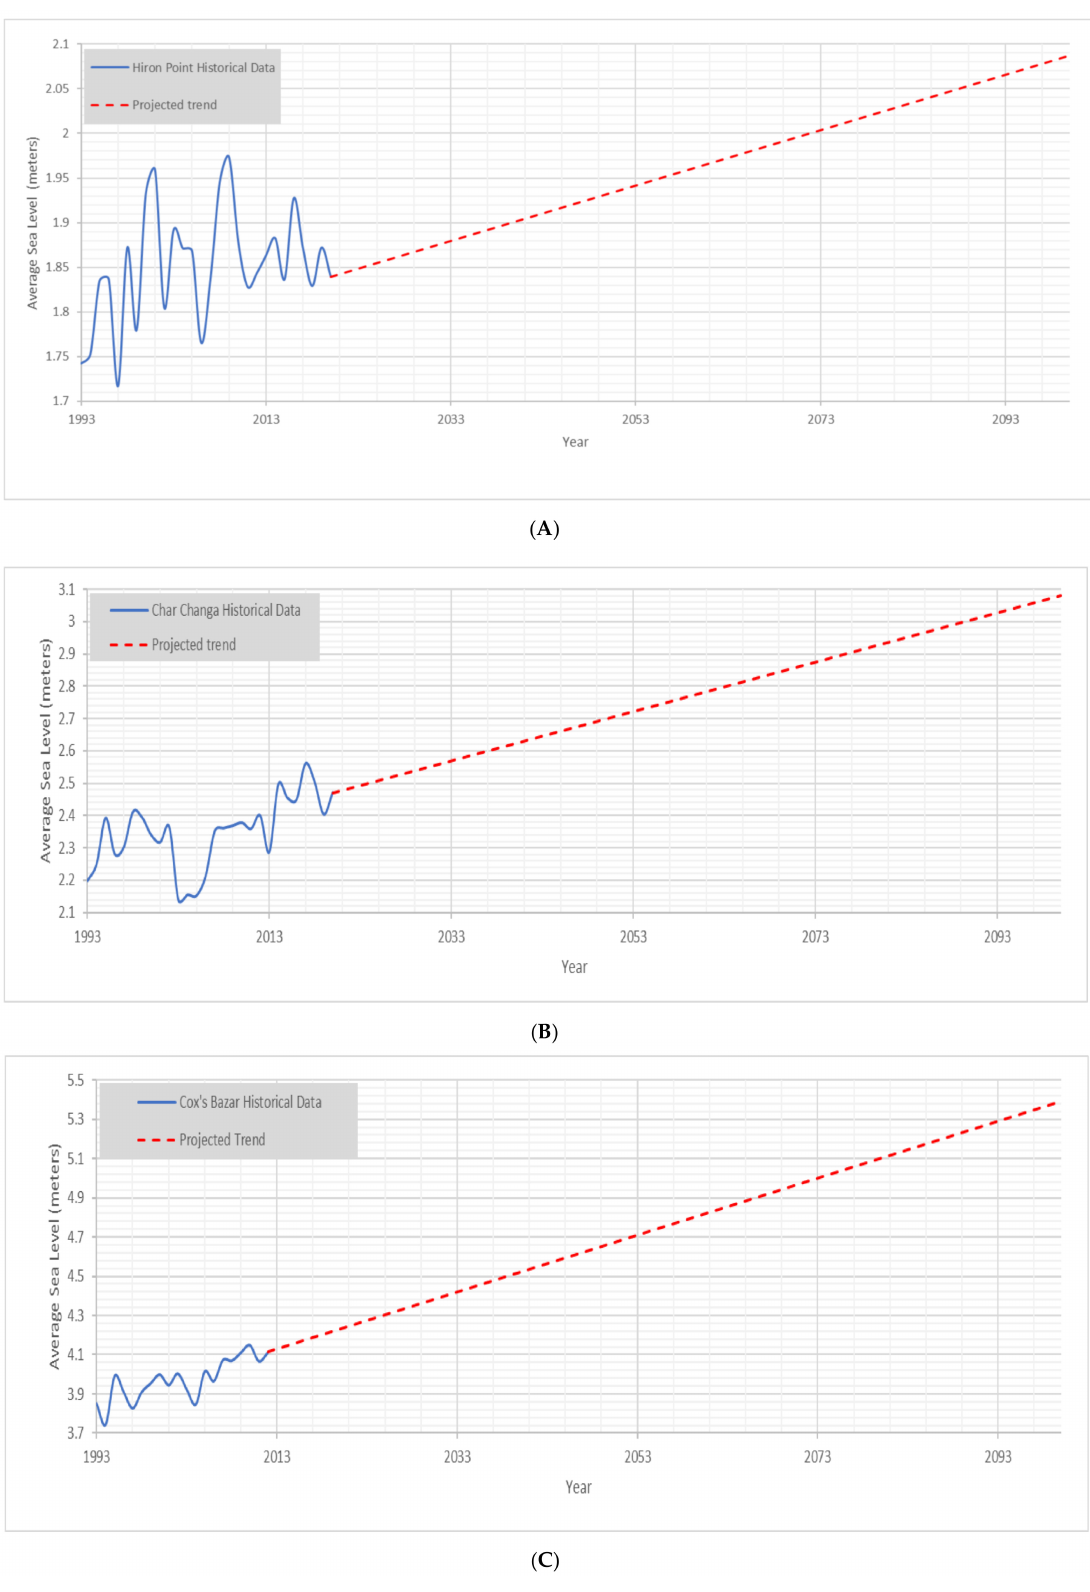
Figure 2. Sea level rise changes for three tide gauges on the coast of Bangladesh, along with the projected trend until 2100, based on the equation for the linear trend line of the historical record. Hiron Point ( A ) and Char Changa ( B ) records from 1993 to 2019, and Cox’s Bazar ( C ) from 1993 to 2011. All stations show an increasing SLR trend (Data Source: BIWTA, 2020, Table